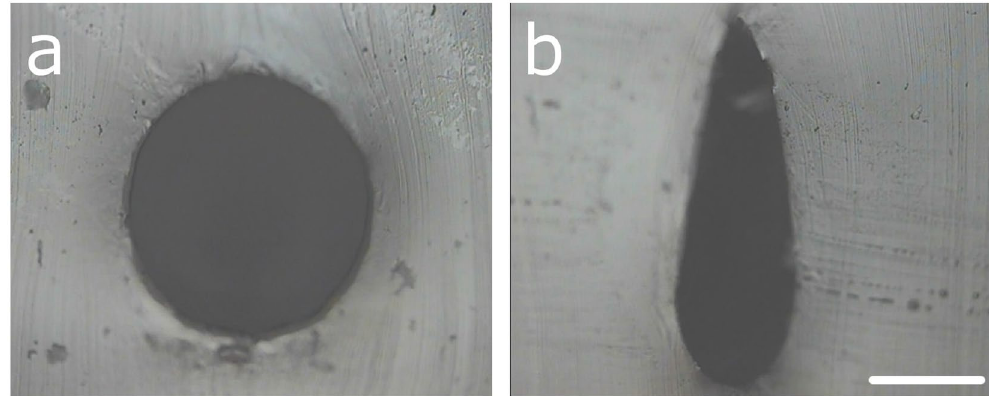
Figure 3. Variation of the channel cross-section and high-aspect ratio channels by capillary wetting effects. ( a ) Circular cross-section achieved by nearly simultaneous start of extrusion and capillary movement. ( b ) High- aspect ratio channels achieved by a delay in capillary movement compared to the start of the extrusion. Scale bar: 250 µ m.